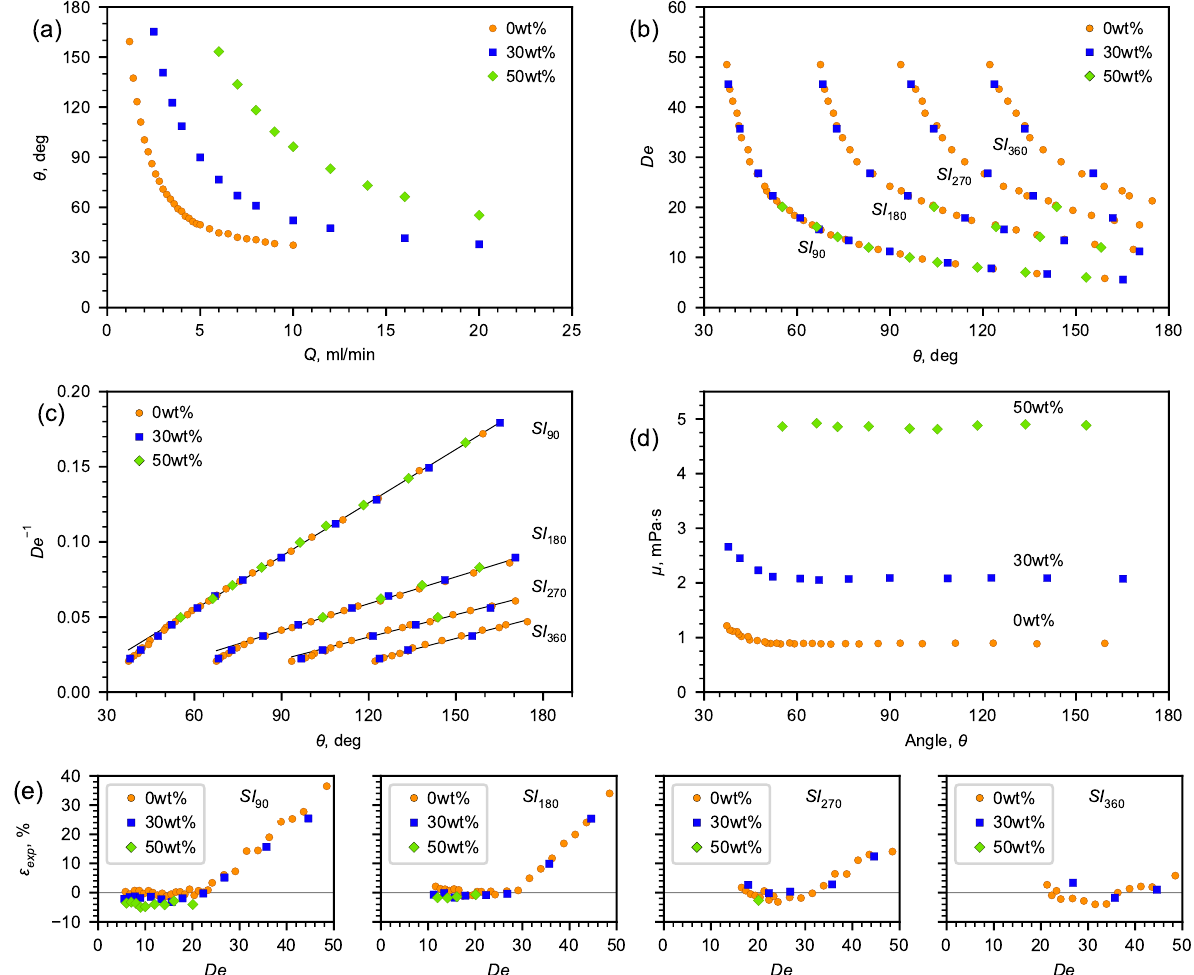
Figure 6. The results of experimental study. ( a ) Dependence of flow recirculation angle SI 90 on fluid flow rate; ( b ) Dean number vs. flow recirculation angle; ( c ) inverse Dean number vs. flow recirculation angle; ( d ) viscosity vs. flow recirculation angle; ( e ) relative deviation between the dynamic viscosity coefficient calculated according to (3) and the reference data [42] in the investigated range of the Dean number.